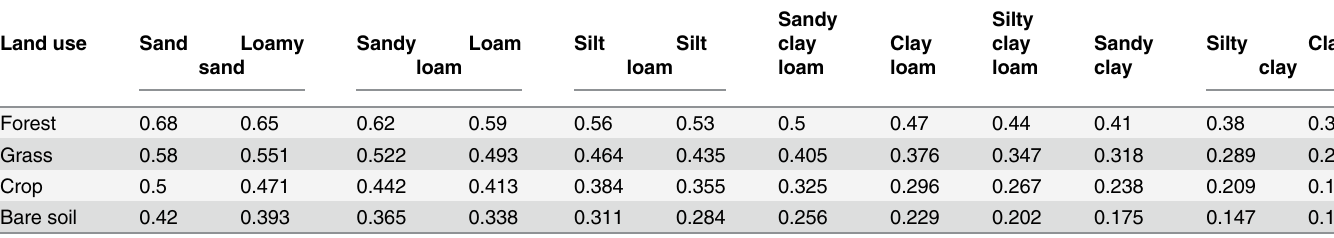
Table 3. Slope constant S 0 for determining potential runoff